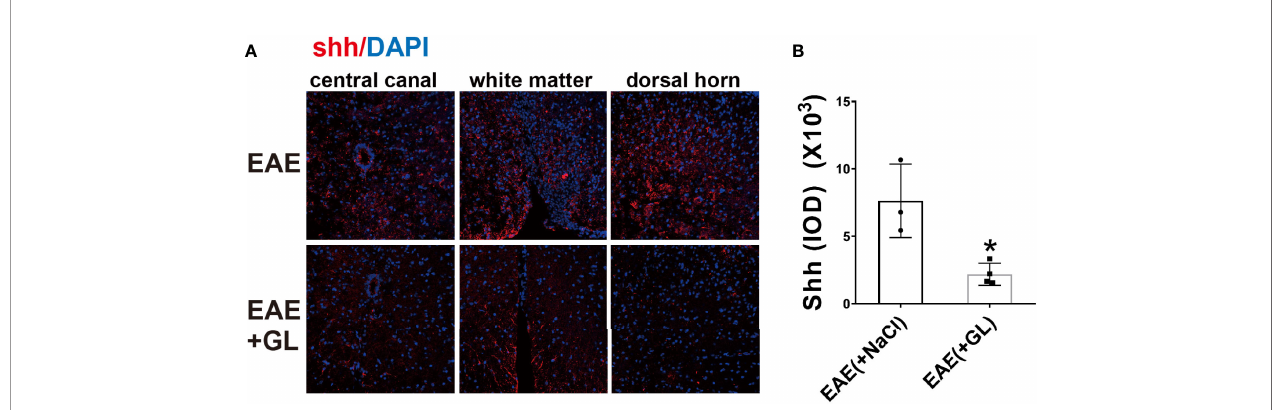
FIGURE 4 | The effect of HMGB1 inhibitor (glycyrrhizin, GL) on the expression of shh in EAE. GL (25mg/kg) was injected intraperitoneally (i.p.) on the onset stage of EAE and the spinal cord tissues were collected on the peak stage. (A) Immuno fl uorescence was used to detect the expression of shh in CNS. Images are representative of 3 or 4 mice in each group and (B) data are shown as mean ± SD. (* P < 0.05).